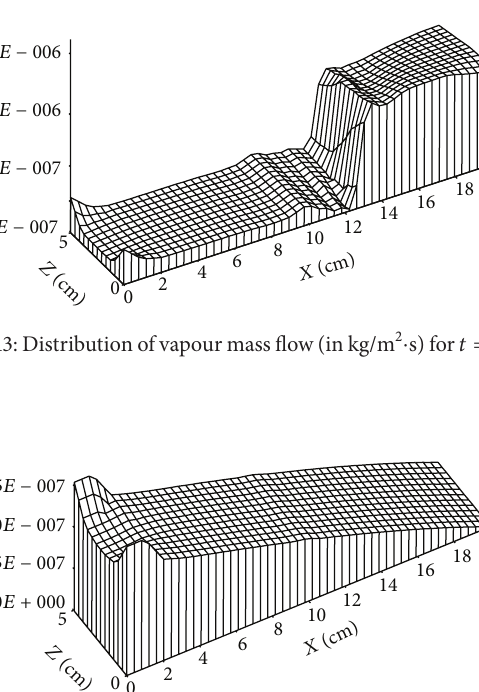
Figure14:Distributionoftotalmassflow(inkg/m 2 ⋅ s)for 𝑡 = 4 days.